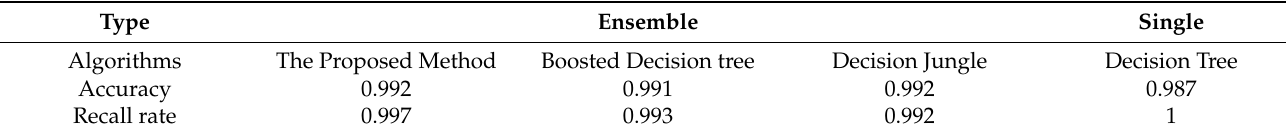
Figure 7. ROC curve of semiconductor case. Table 6. Results of blister packing machine case.